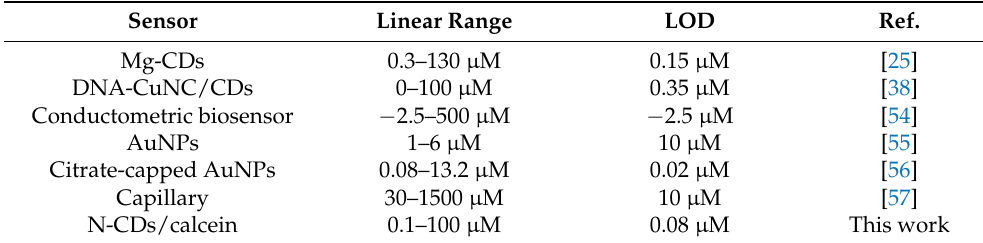
Figure 11. ( a ) Fluorescence intensity emission spectra of N-CD/calcein sensor with Arg addition. Insets show fluorescence color change of N-CD/calcein sensor in the absence (left) and presence (right) of the addition of 100 μ M Arg. ( b ) Fitting curve between F 1 /F 2 and C Arg . Insets show fluorescence color change of N-CD/calcein sensor with increased C Arg (from left to right). Table 1. Comparison of different sensors for Arg